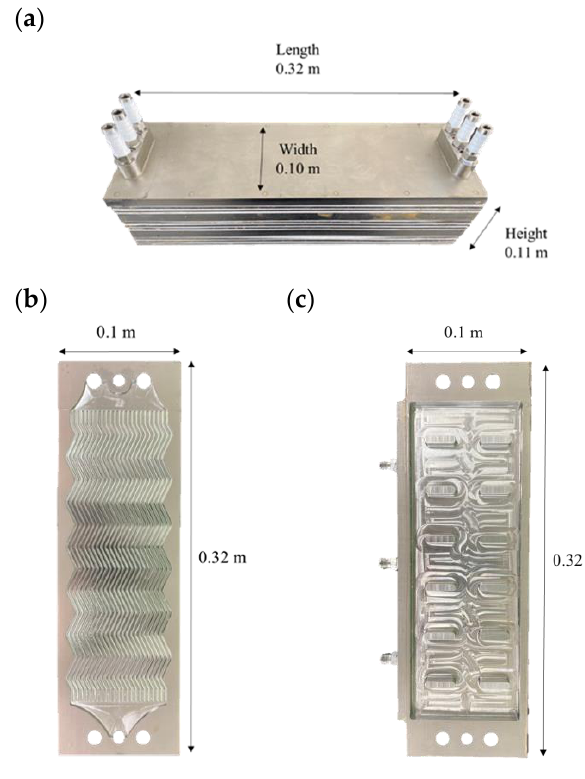
Figure 1. The photos and dimensions of ( a ) the PHE, ( b ) the flow channel plate, and ( c ) the PCM plate.